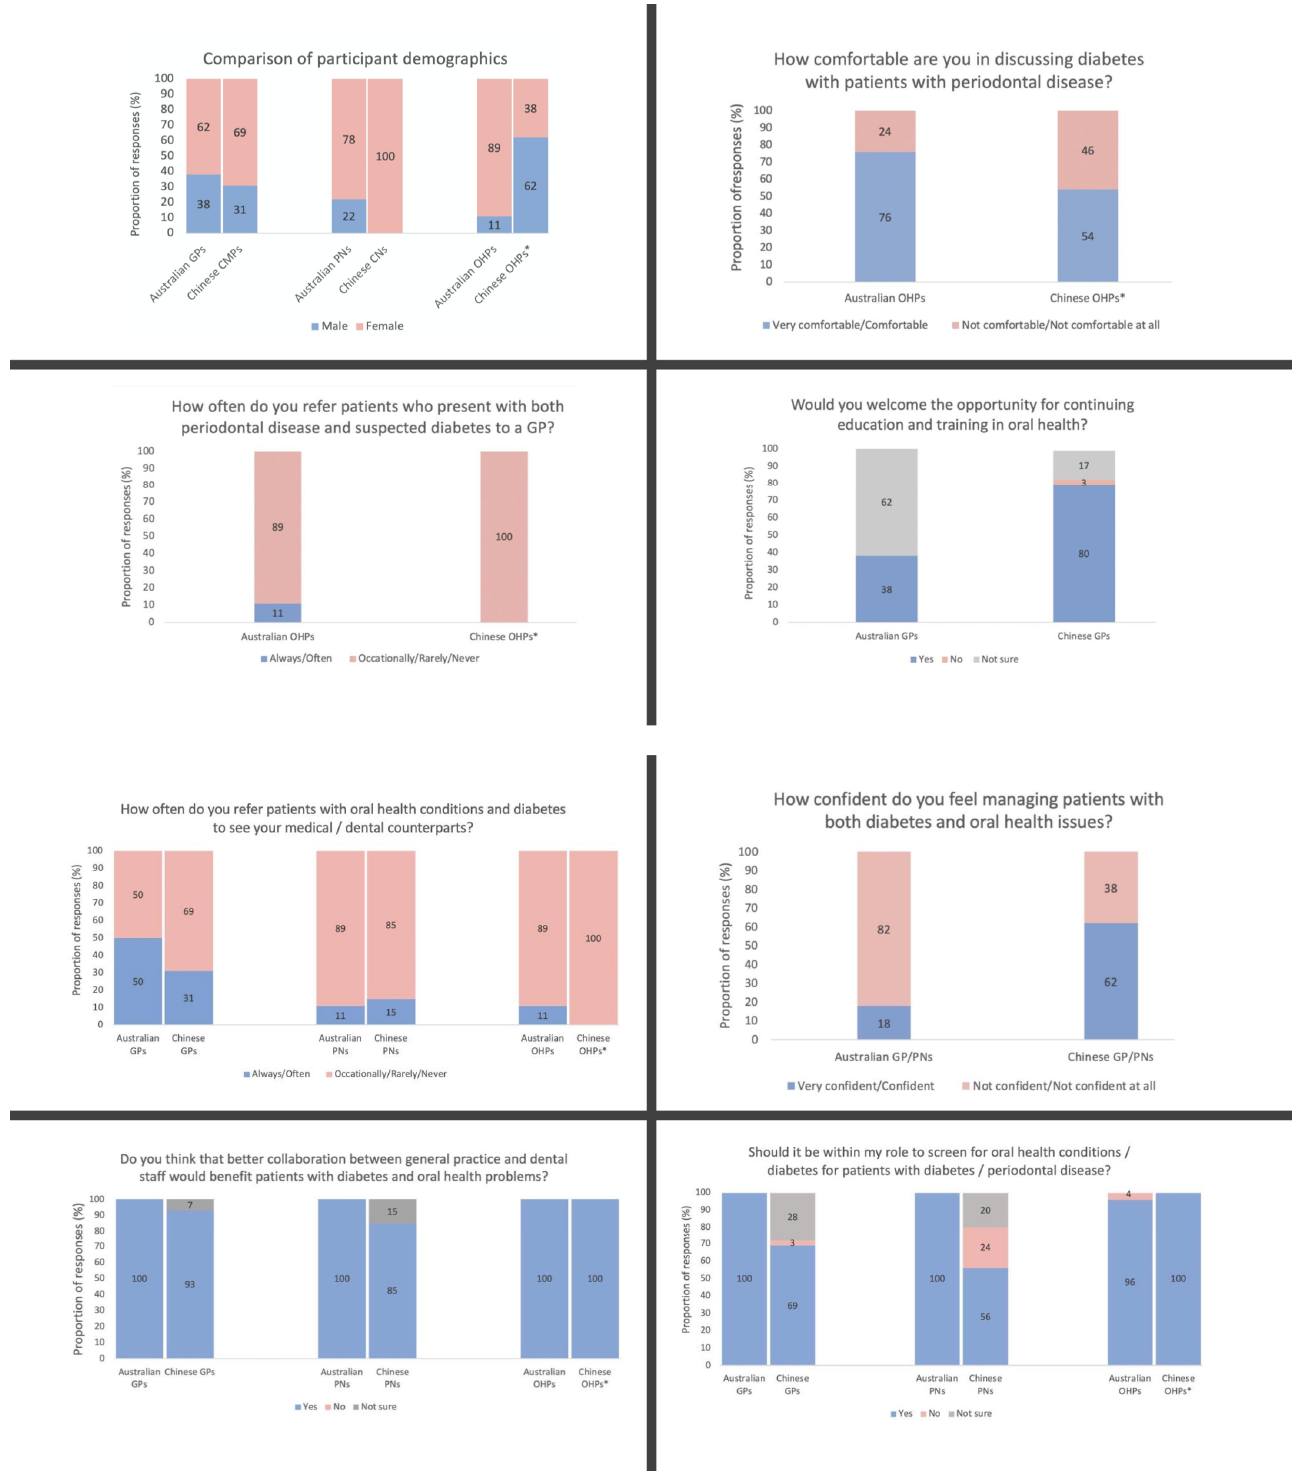
Figure 1. Comparisons between participant responses in this study and those in the Melbourne study [17] (* all OHP participants in Shanghai were dentists). study [17] (* all OHP participants in Shanghai were